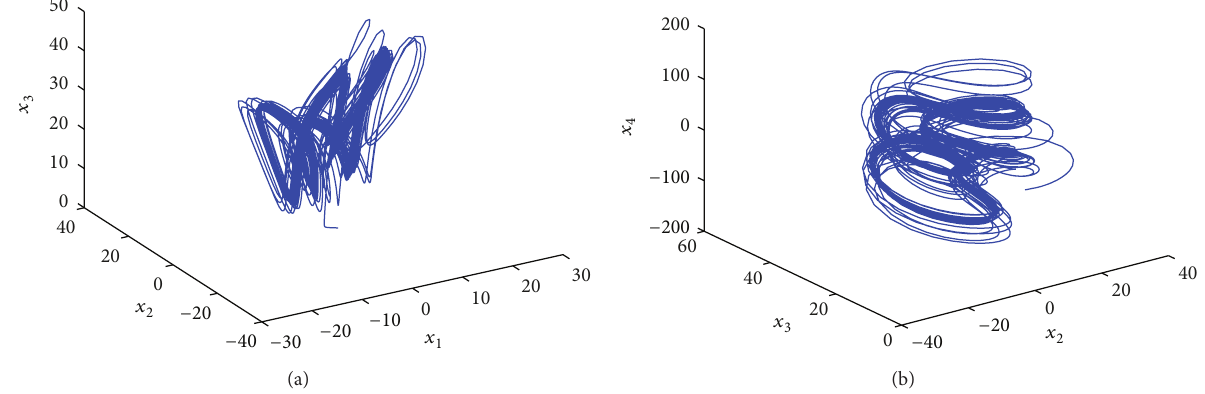
Figure 4: Hyperchaotic attractors in the fractional-order hyperchaotic Lorenz system with 𝛼 = 0.99 . The panels (a) and (b) show the 3D views of 𝑥 3 − 𝑥 2 − 𝑥 1 and 𝑥 4 − 𝑥 3 − 𝑥 2 ,